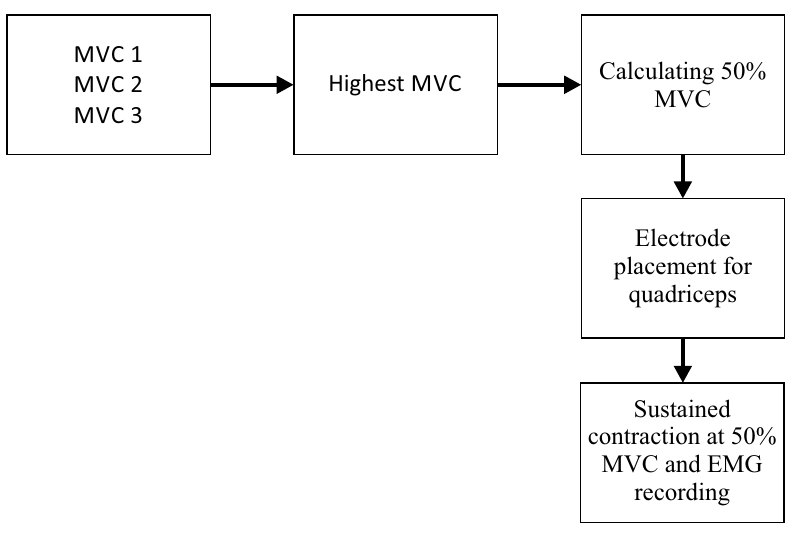
Figure 1. The procedure of the experiment.